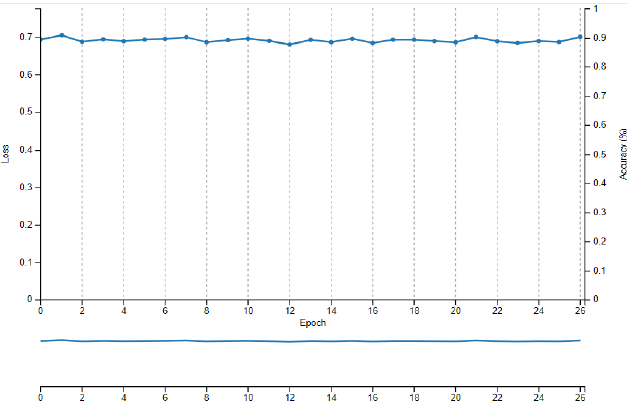
Figure 5. Performance Analysis of Loss rate during Training